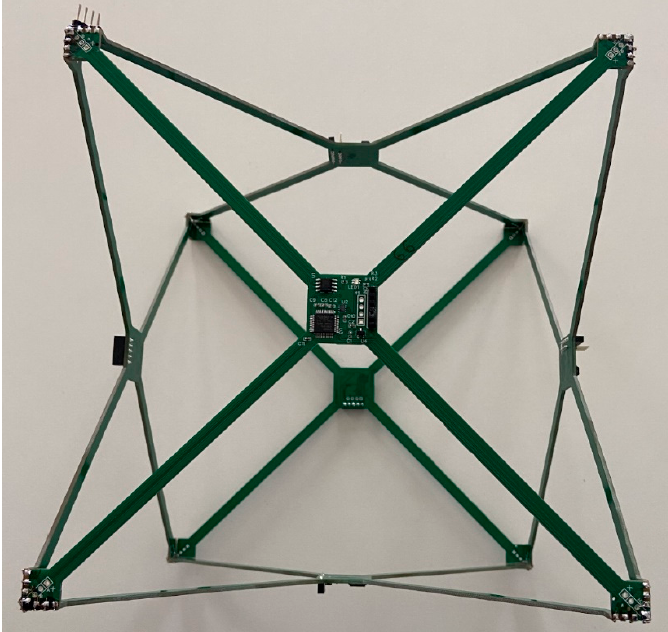
Figure 1. Multipoint pressure measurement system.